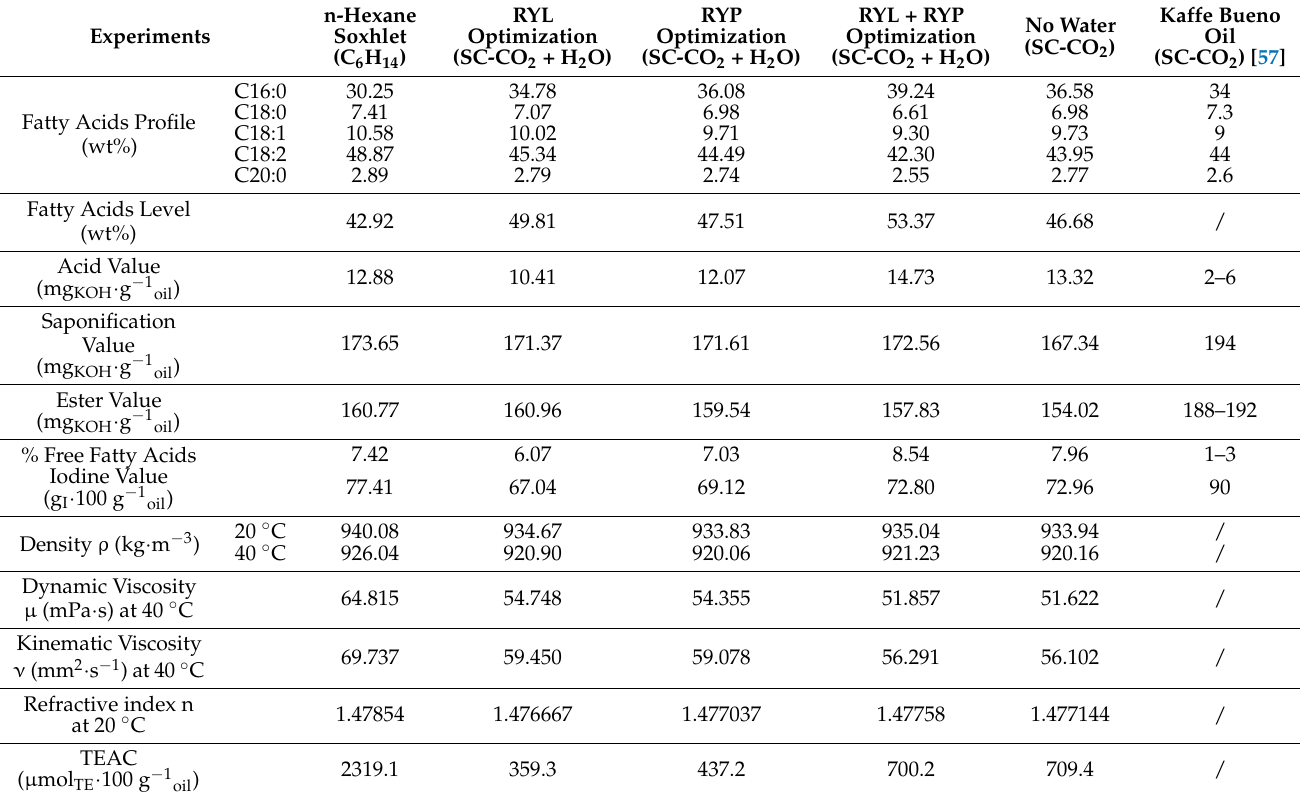
Table 5. Characterization of lipids fractions by GC-MS for Fatty Acids Profile (FAP) and Fatty Acids Level (FAL), by colorimetric titration for Acid Value (AV), Saponification Value (SV), Ester Value (EV), and Iodine Value (IV), by physico-chemical analyses for Density, Dynamic Viscosity, Kinematic Viscosity, Refractive Index, and UV-Visible spectrophotometer for Trolox Equivalent Antioxidant Capacity